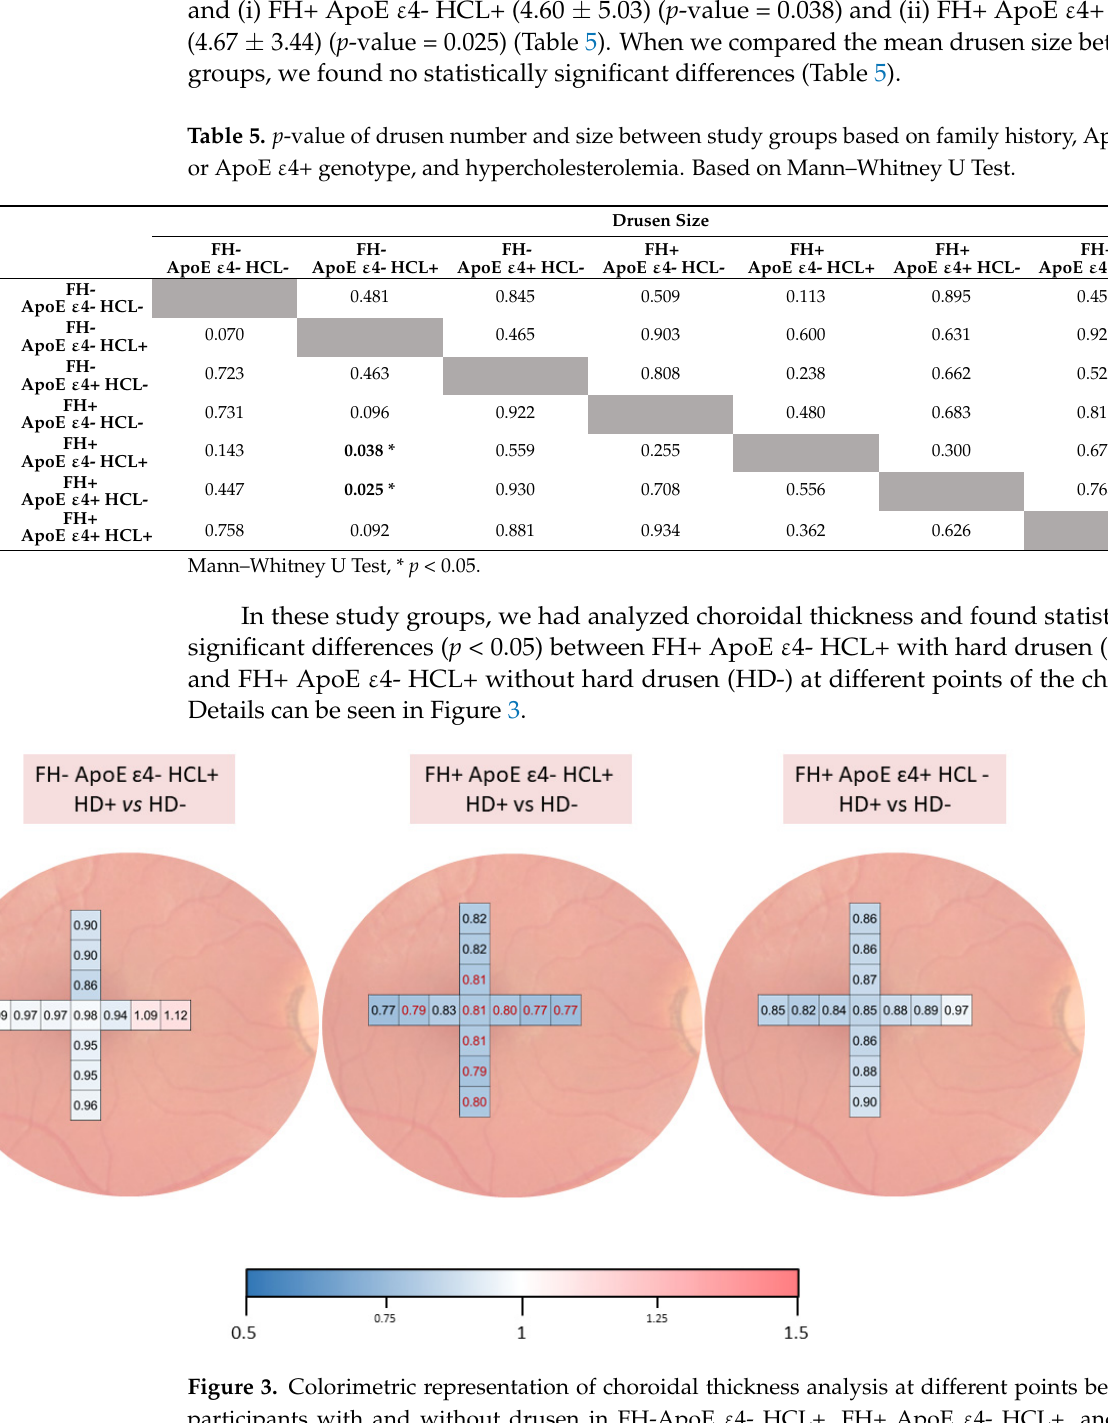
Table 6. Characterization of drusen by FH, ApoE genotype, and HBP. FH- ApoE ɛ 4- HBP-